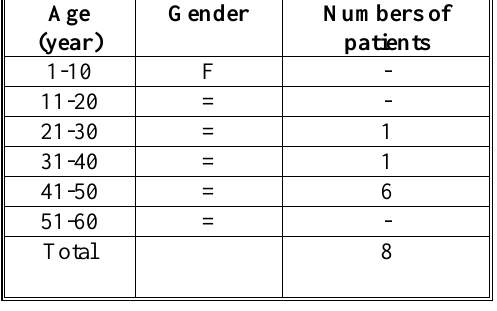
Table ( 5 ) Age distribution of anti H.pylori IgA positive serum samples in females